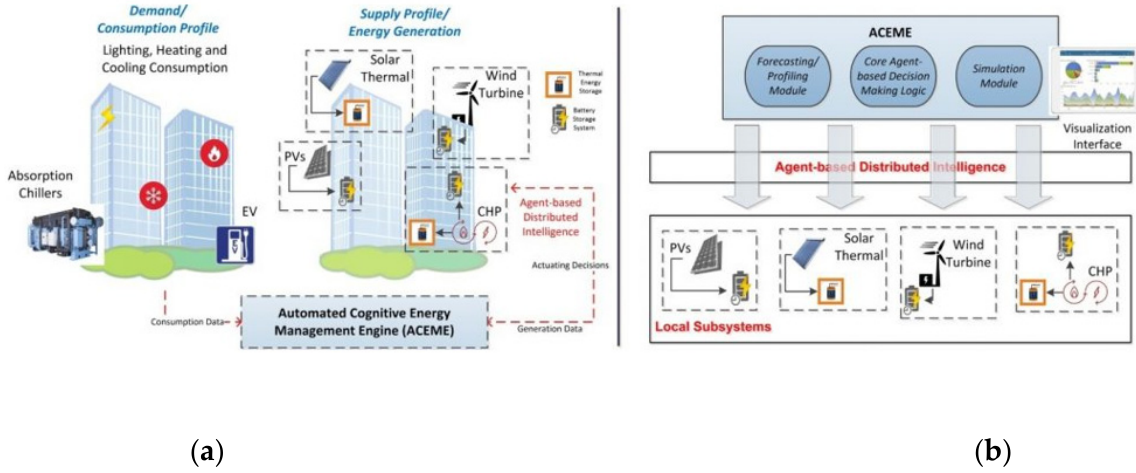
Figure 3. Schematic of the European project RE-COGNITION: ( a ) First aim of the project: new renewable technologies development; ( b ) Second aim of the project: platform development.